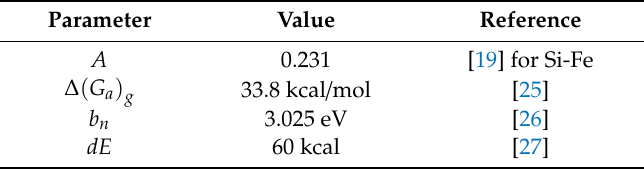
Table 3. Material parameters of recrystallization